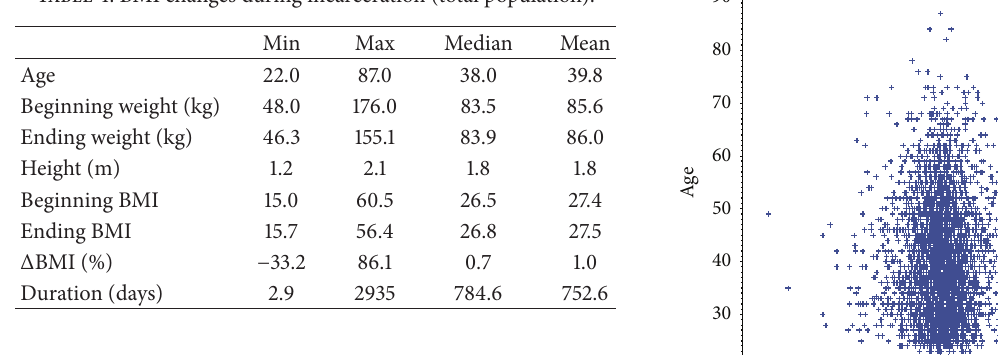
Table 4: BMI changes during incarceration (total population).